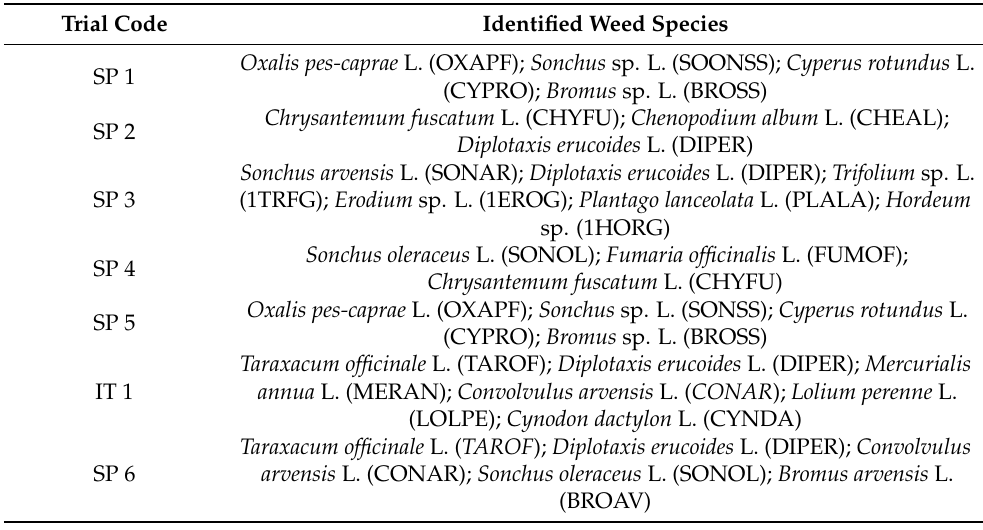
Table 7. Identified weed species in each field trial.